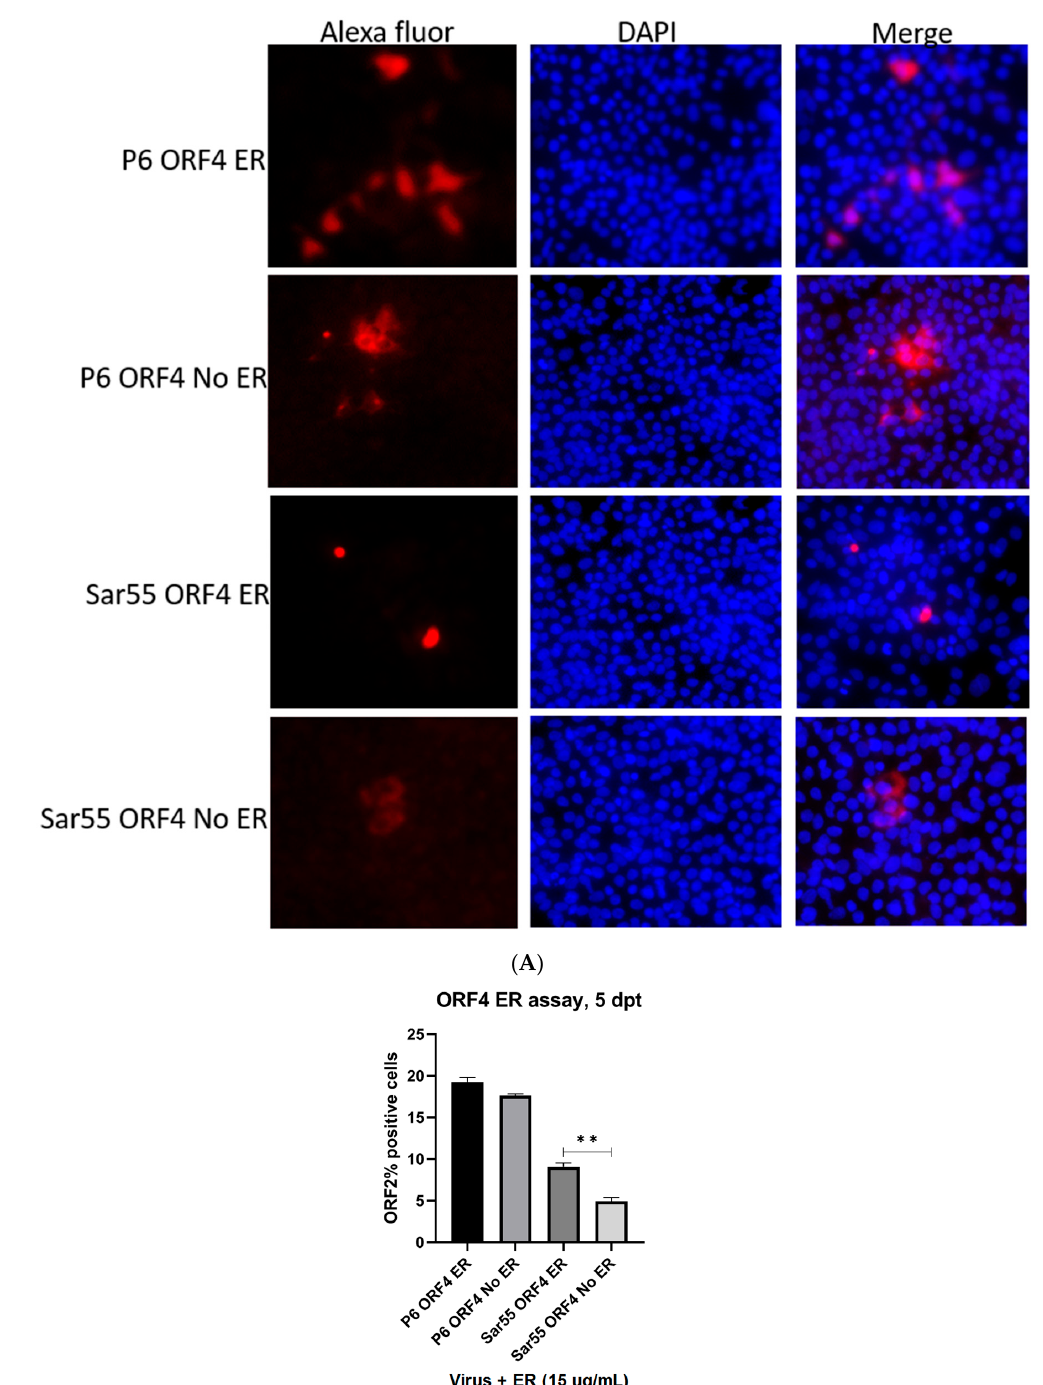
Figure 6. Sar55 replication enhanced in ORF4 − expressing Huh7 cell lines treated with Tunicamycin. ( A ) Immunofluores- cence detection of HEV ORF2 antigen in methanol fixed ORF4+ Huh7 cell treated with 15 µg/mL tunicamycin after 5 dpt with Alexa fluor 594 (red) and DAPI (blue). ( B ) Flow cytometry quantification of ORF4+ Huh7 cells transfected with the capped RNA transcripts of the HEV gt3 (P6) strain and HEV gt1 (Sar55) strain, performed at 5 dpt. Samples were fixed in methanol and probed with rabbit anti-ORF2 followed by goat anti-rabbit PE antibodies. Each bar (mean ± SEM) represents separate transfections stained in parallel and display the mean of three independent biological experiments with nine replicates per sample (** p < 0.01, t -test). Statistically significant difference exists between Sar55 transfected, endoplasmic stressor (tunicamycin) treated ORF4+ cell lines and untreated cell